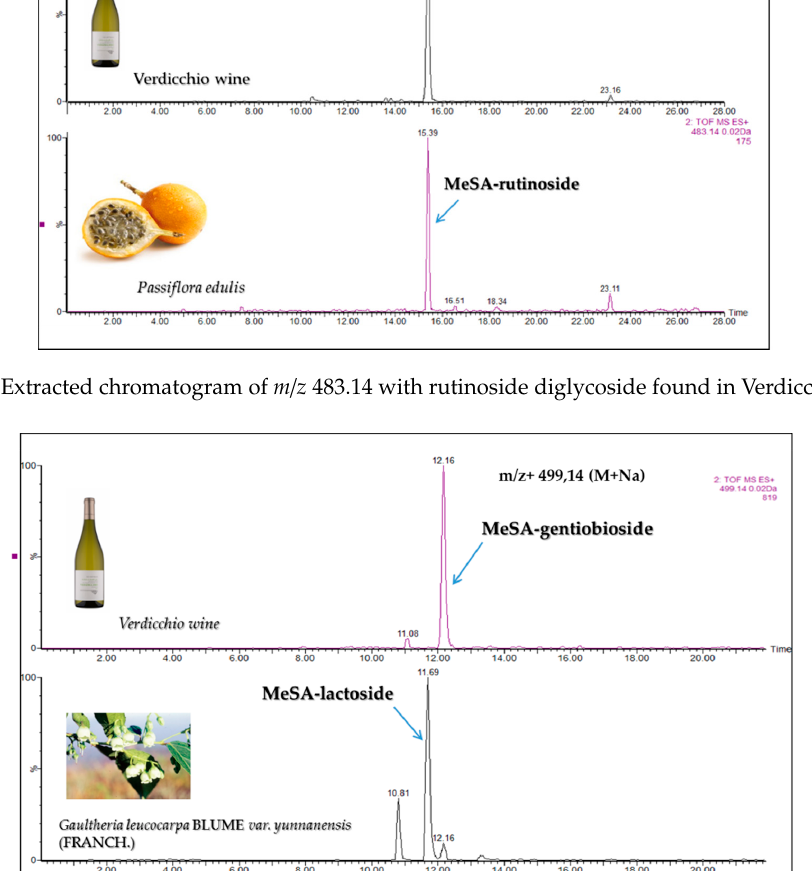
Figure 4. Structural formulas of the compounds isolated from the dried leaves of Gaultheria procumbens L . MeSA β - D -xylosyl-(1 → 6)- β - D -glucose (gaultherin) ( 1 ), MeSA xyloyl-[1 → 6]-xylosyl- [1 → 2]-glucose (MeSA-MSTG-A) ( 2 ), MeSA β - D -xylosyl-(1 → 2)- β - D -glucose (sambubiose) ( 3 ), MeSA β - D -glucosyl-(1 → 2)- β - D -glucose (sophorose) ( 4 ) . 1 H-NMR ( 1 , 400 MHz, Methanol-d 4 ): 7.76 (ddd, J = 7.8, 1.8, 0.3 Hz, H-6,1H), 7.57 (ddd, J = 8.4, 7.3, 1.8 Hz, H-4,1H), 7.45 (ddd, J = 8.3 , 1.1, 0.3 Hz, H-3, 1H), 7.13 (ddd,7.8, 7.3,1.1 Hz, H-5, 1H), 4.87 (d, J = 7.4 Hz, H-1 ′ , 1H), 4.33 (d, J = 7.4 Hz, H-1 ′′ , 1H), 4.13 (dd, J = 11.7, 1.8 Hz, H-6 ′ b,1H) and 3.78 (dd, J = 11.7, 6.5 Hz, H-6’a,1H), 3.89 (s, 3H, OMe), 3.84 (dd, J = 11.5, 5.3 Hz, H-5 ′′ eq,1H) and 3.15 (dd, J = 11.5, 10.2 Hz, H-5 ′′ ax, 1H), 3.66 (ddd, 10.2, 8.7, 5.3 Hz, H-4 ′′ , 1H), 3.53 (dd, 7.4, 8.7 Hz, H2’,1H), 3.47 (dd, 9.7,9.7 Hz, H-3 ′′ , 1H), 3.45 (m, H-5 ′ , 1H), 3.29 (dd, 8.7,8.7 Hz, H-3 ′ , 1H), 3.21 (dd, J = 9.0, 7.4 Hz, H-2 ′′ ,1H). 13 C-NMR ( 1 , 100 MHz, Methanol-d 4 ): 168.1(–COCH3 3 ) , 158.2 (C-2), 135.0 (C-4), 131.7 (C-6), 123.5 (C-5), 122.0 (C-1), 118.9 (C-3), 105.2 (C-1 ′′ ), 103.6 (C-1 ′ ), 78.0 (C-3’) , 77.7 (C-3 ′′ ), 77.2 (C-5 ′ ), 74.7 (C-2 ′ ), 71.2 (C-4 ′ ), 71.0 (C-4 ′′ ), 69.6 (C-6 ′ ), 66.6 (C-5 ′′ ), 52.2 (–OCH 3 ).